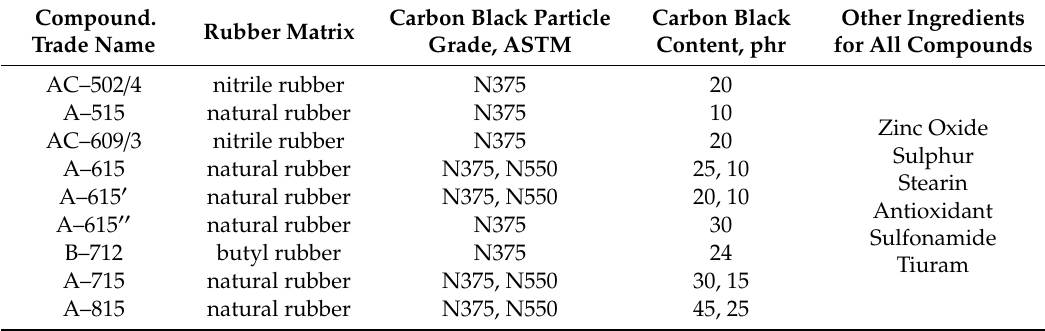
Table 3. Composition of compounds manufactured by company “TIGAR technical rubber”.